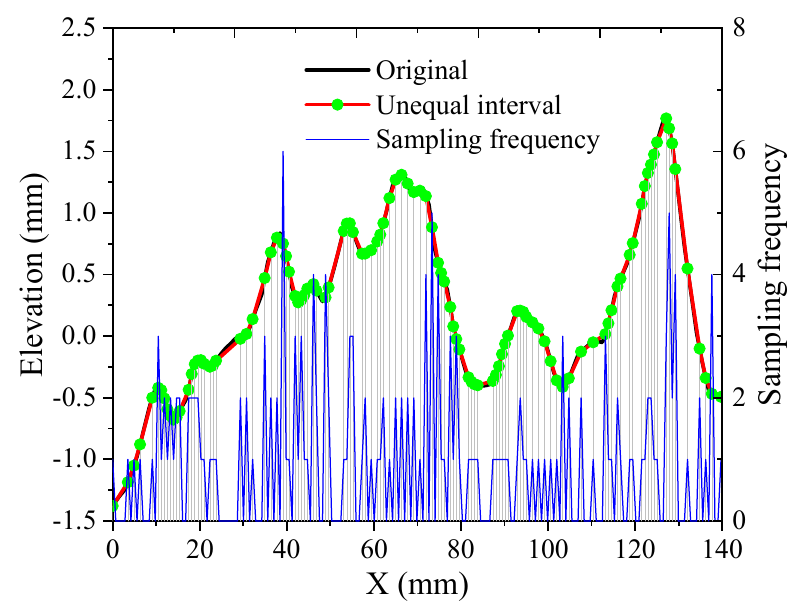
Figure 10. Non-equidistant sampling frequency and its profiles of L1. Table 1. Relative error of roughness calculation using non-equidistant methods. Roughness